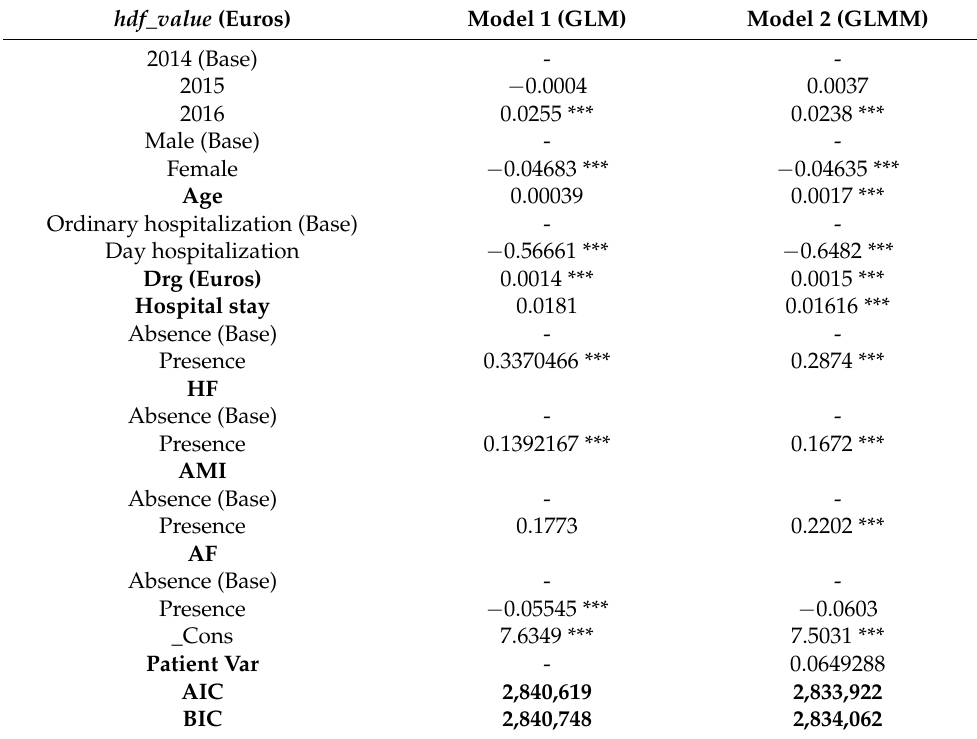
Table 4. Results of the generalized linear model with gamma distribution and log